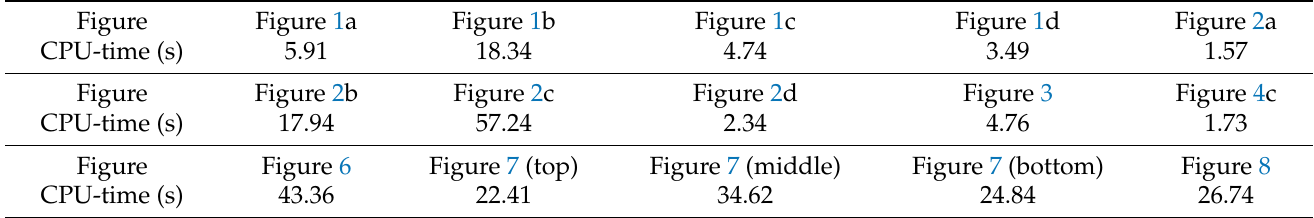
Table 4. Total CPU-time of every numerical test in this